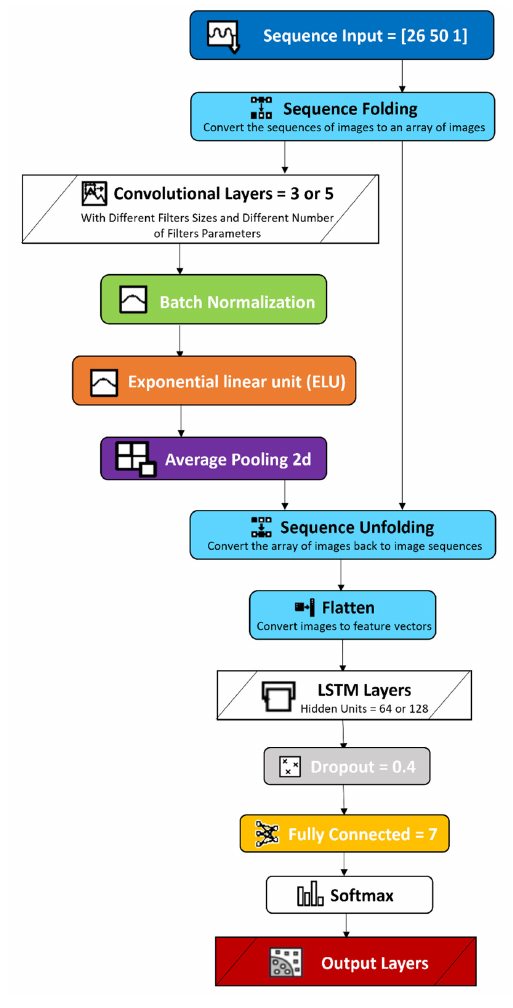
Figure 3. CRNN architecture.